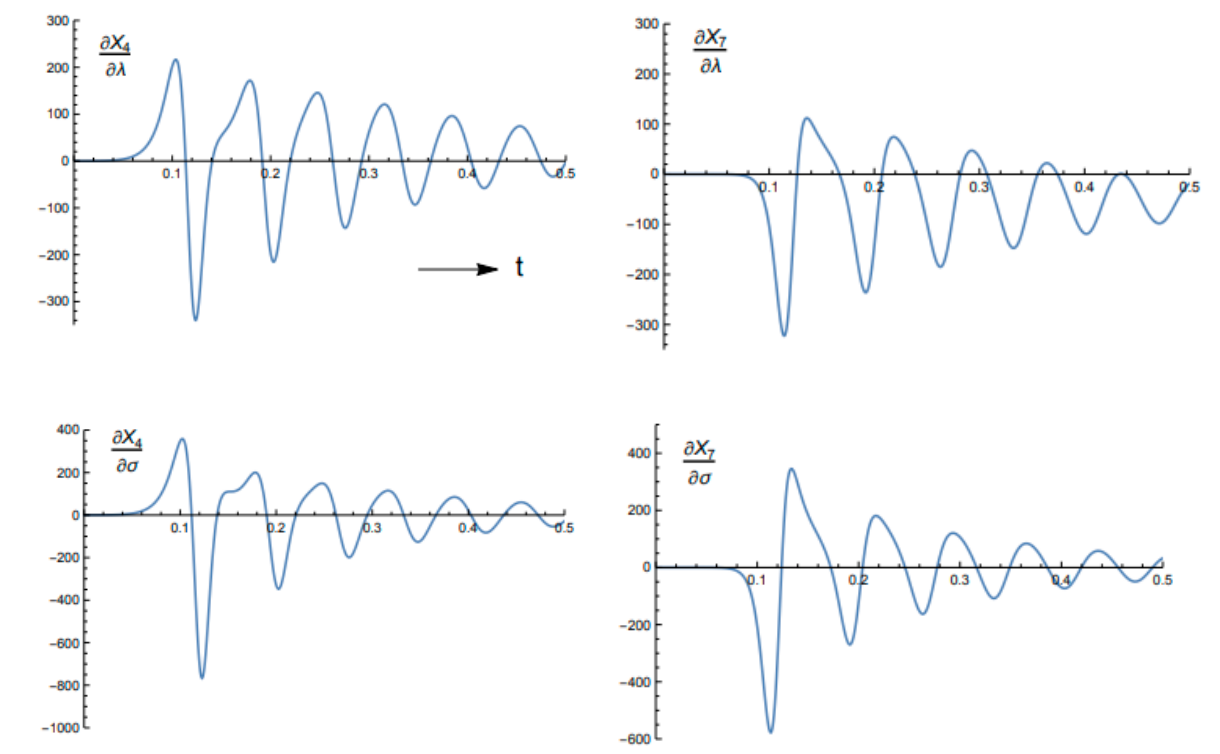
Figure 12. S-LOM (3) forecast sensitivity of x 4 and x 7 to controls for the non-chaotic regime. Results from the data assimilation experiment are shown in Table 3. The data assimila- tion process converges to ( λ , σ ) = ( 13.8, 4.8 ) in 4 iterations. The cost function is reduced 9 orders of magnitude. The cost function for this case is shown in Figure 13. The converged values of control shown in Table 3 are consistent with this cost function’s minimum.